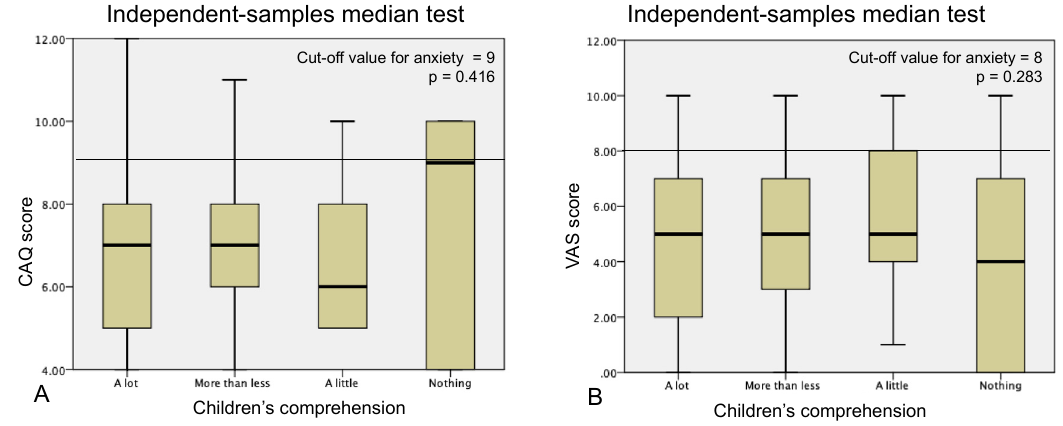
Figure 2. Comparison of children’s anxiety scores on CAQ ( A ) and NRS ( B ), according to their perceived comprehension level of the current situation. Kruskal–Wallis test for independent median comparisons.